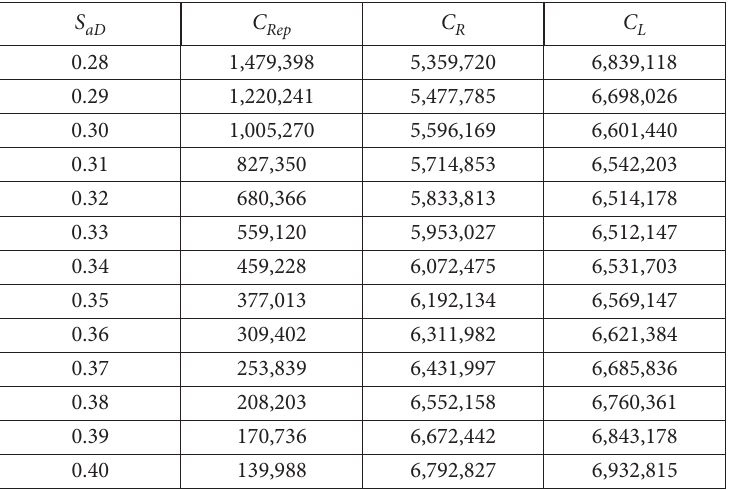
Table 8. Life-cycle cost of a retrofitted school building under seismic risk (NTD) S